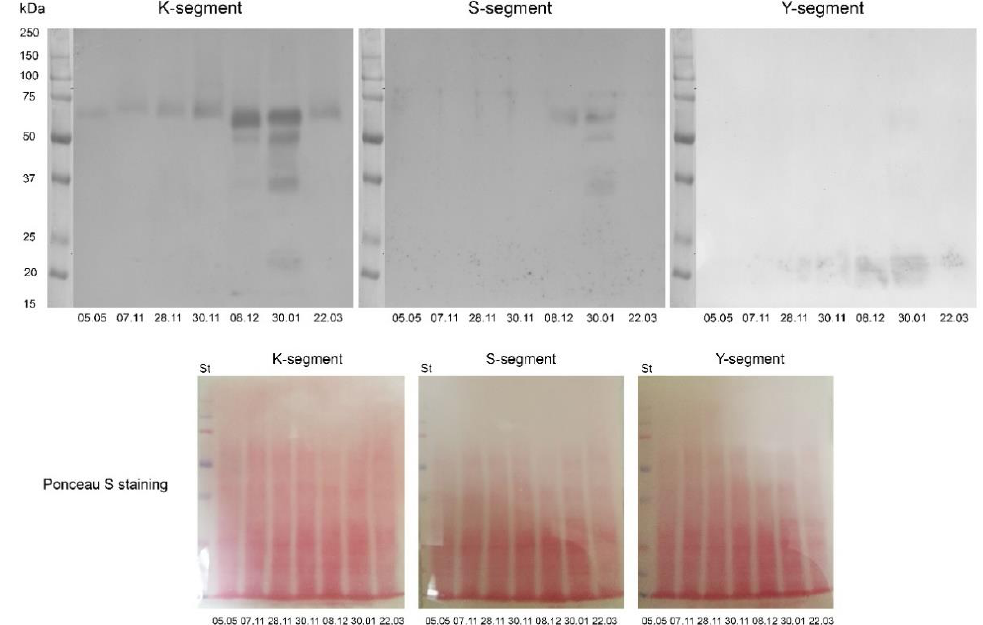
Figure 8. Representative Western blots of dehydrins ( top ) in leaves of Haberlea rhodopensis after exposure to low temperatures during cold acclimation (CA, period: 7–28 November), freezing stress (FS, 30 November, − 10 ◦ C), freezing-induced desiccation (FS + D, period: 8 December–30 January) and after recovery of plants in early spring (R; period: 22 March) under natural ex situ environmental conditions detected by Western blot using antibodies against the conserved K-, S- and Y-segment of the proteins. 30 µ g protein was applied per lane. Ponceau S staining of the membranes after blotting is presented below the Western blots. St: Precision Plus Dual Color Protein™ Prestained Standards (Bio-Rad, Hercules, CA, USA).